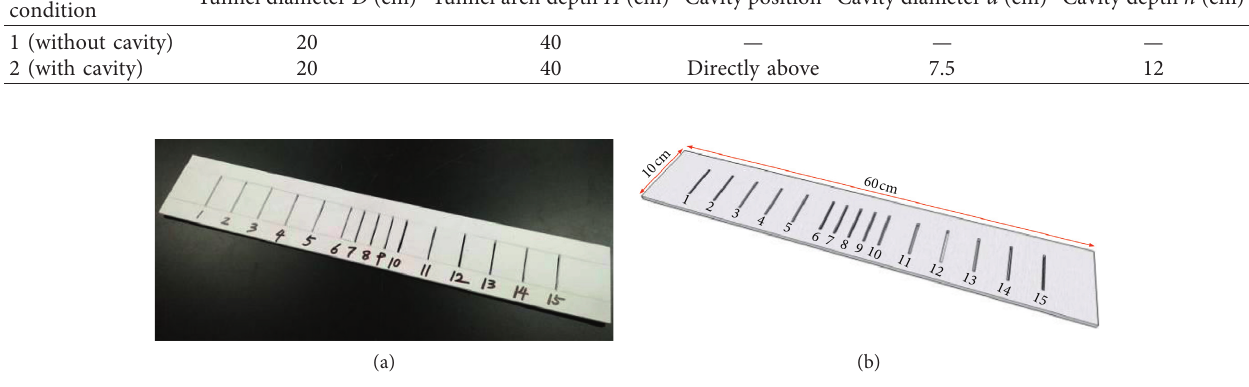
Figure 4: Scaling ruler. (a) Physical drawing. (b) Impression drawing.